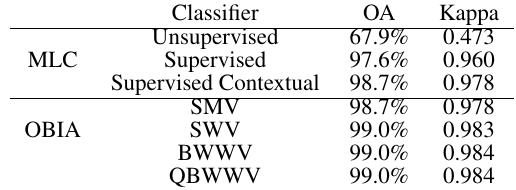
Table 3. Overall accuracy and Coen’s Kappa for